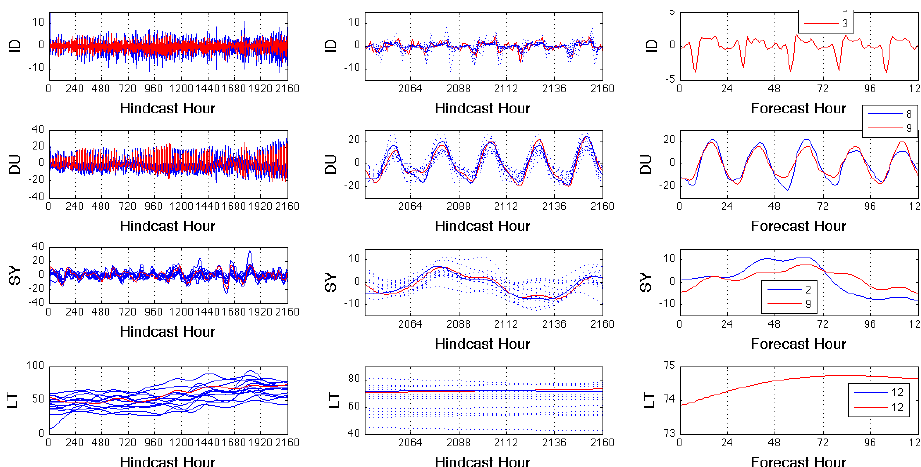
Fig. 2. Illustrative example of the computational strategy for one case (of the 175). Left column: the spectral components of the observations and all deterministic models ( H -step). Middle column: the spectral components of the observations and all deterministic models during the EXTRACT week (H-step). In this example, the model id’s that produced the least RMSE (shown in thick blue) in the spectral components are: ID(3), DU(8), SY(2), LT(12). Right column: the spectral components of the deterministic models identified in the EXTRACT week are re-calculated for the F period and shown for the PREDICT week (in blue) together with the actual (in red) optimal components ( F -step). Table 4. The characteristics of the working domains. Sub-Region Longitude Latitude Ensemble Number of receptors Members in the aggregation from to from to U